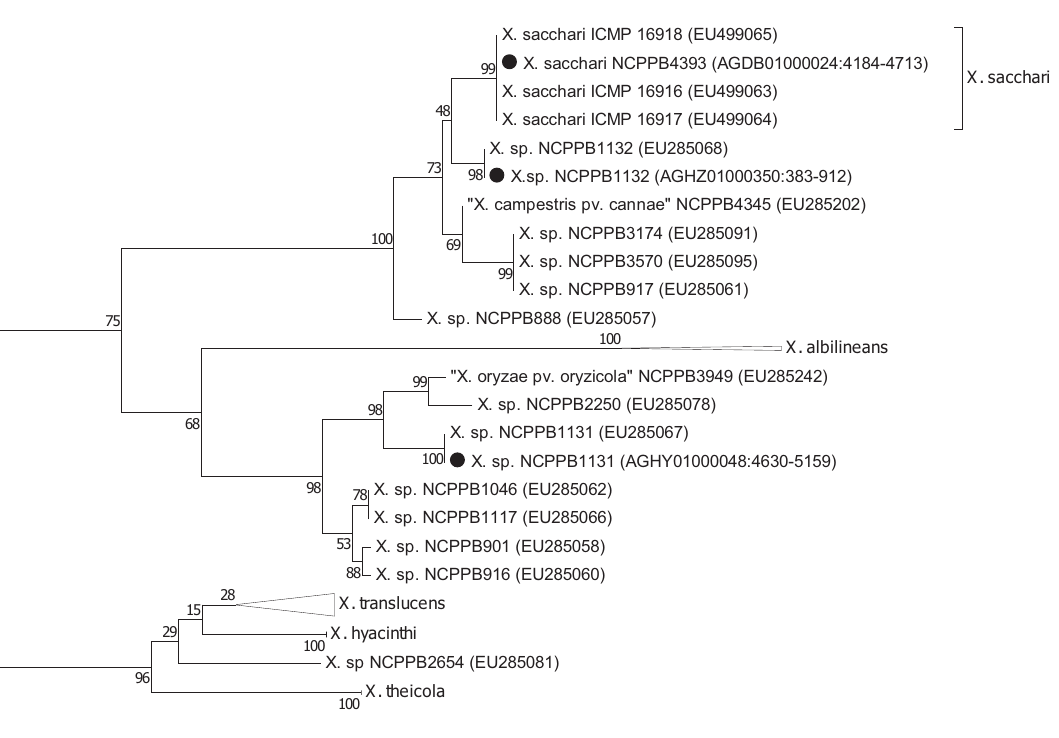
Figure 2. Phylogenetic positions of the three newly sequenced strains within Xanthomonas Group 1. The figure shows the evolutionary history of the gyrB gene as inferred by using the Maximum Likelihood method based on the Tamura-Nei model [13]. The tree with the highest log likelihood ((cid:3)7358.2201) is shown. The percentage of trees in which the associated taxa clustered together is shown next to the branches. Initial tree(s) for the heuristic search were obtained automatically as follows. When the number of common sites was <100 or less than one fourth of the total number of sites, the maximum parsimony method was used; otherwise BIONJ method with MCL distance matrix was used. The tree is drawn to scale, with branch lengths measured in the number of substitutions per site. The analysis involved 219 nucleotide sequences, taken from the studies by Young and colleagues [5] and Parkinson and colleagues [6] as well as from the three newly sequenced strains. GenBank accession numbers are indicated for the sequences. However, for clarity, only the sub-tree corresponding to Group 1 is shown. The full length of each GenBank sequence entry was used for all of the Young [5] and Parkinson [6] sequences. For the sequences taken from our data, the coordinates of the subsequence are given in the parentheses, following the GenBank accession. All positions containing gaps and missing data were eliminated. There were a total of 517 positions in the final dataset. Evolutionary analyses were conducted in MEGA5 [14]. The newly sequenced strains are indicated by black circles